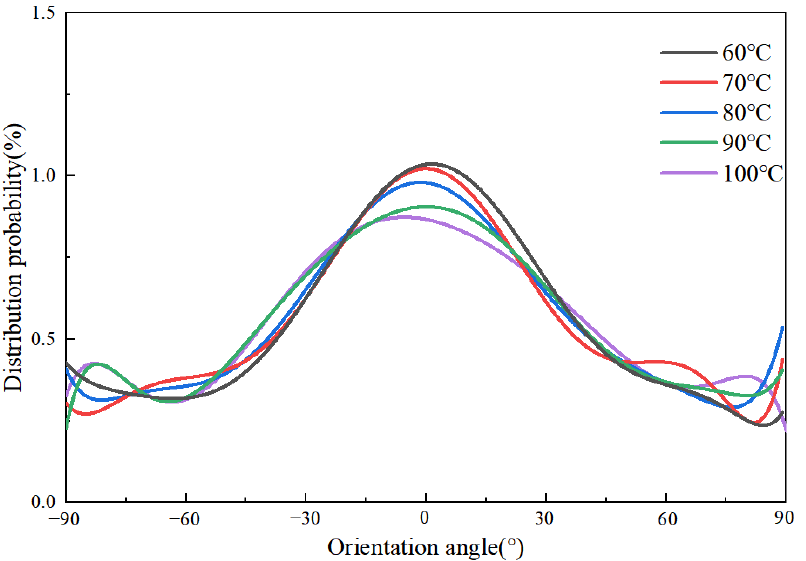
Figure 10. Orientation angle distributions of PP at different mold temperatures along the flow direction.